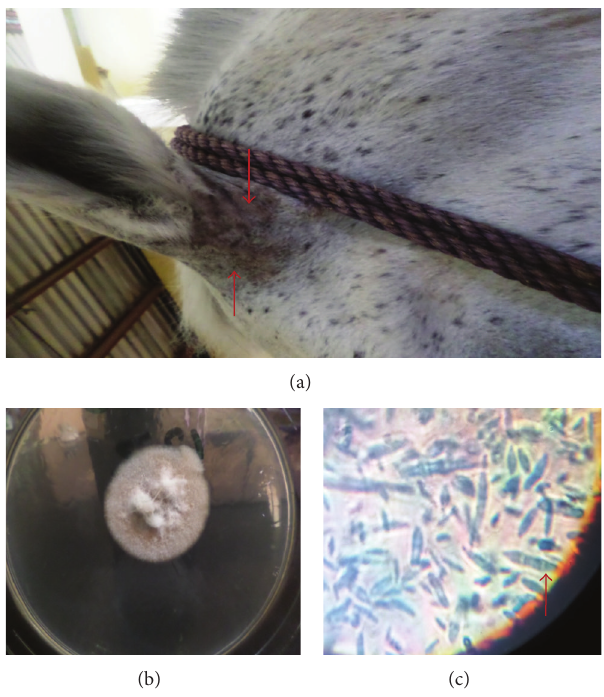
Figure 8: Area of alopecia on the base of an ear of a horse from which M. fulvum was isolated (a), pinkish-buff colony of M. fulvum (8 days) with central white tuft of mycelium (b), and one- to three- celled macroconidia with tapered ends (c) (LCB × 400).